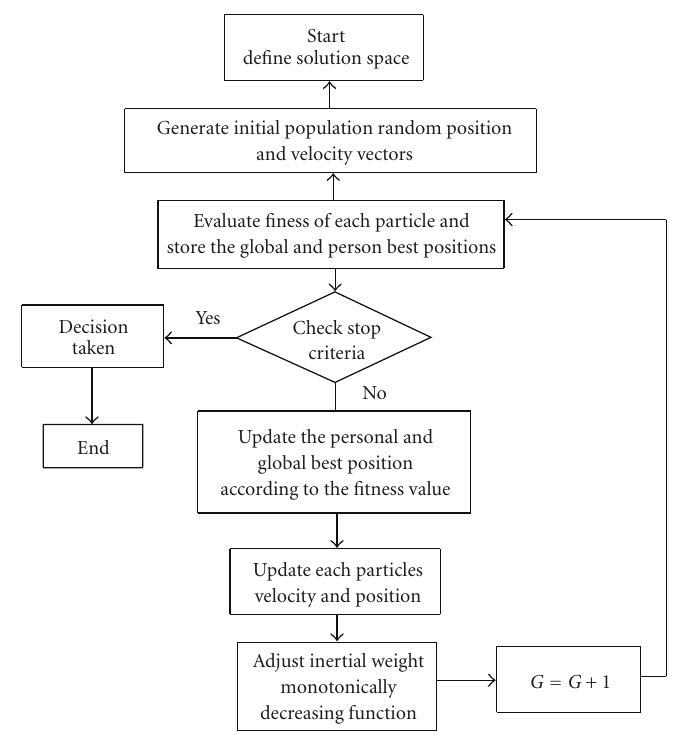
Figure 2: MPSO algorithm